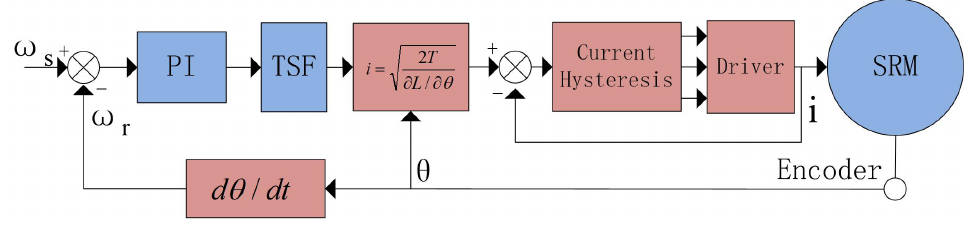
Figure 1. TSF control schematic.